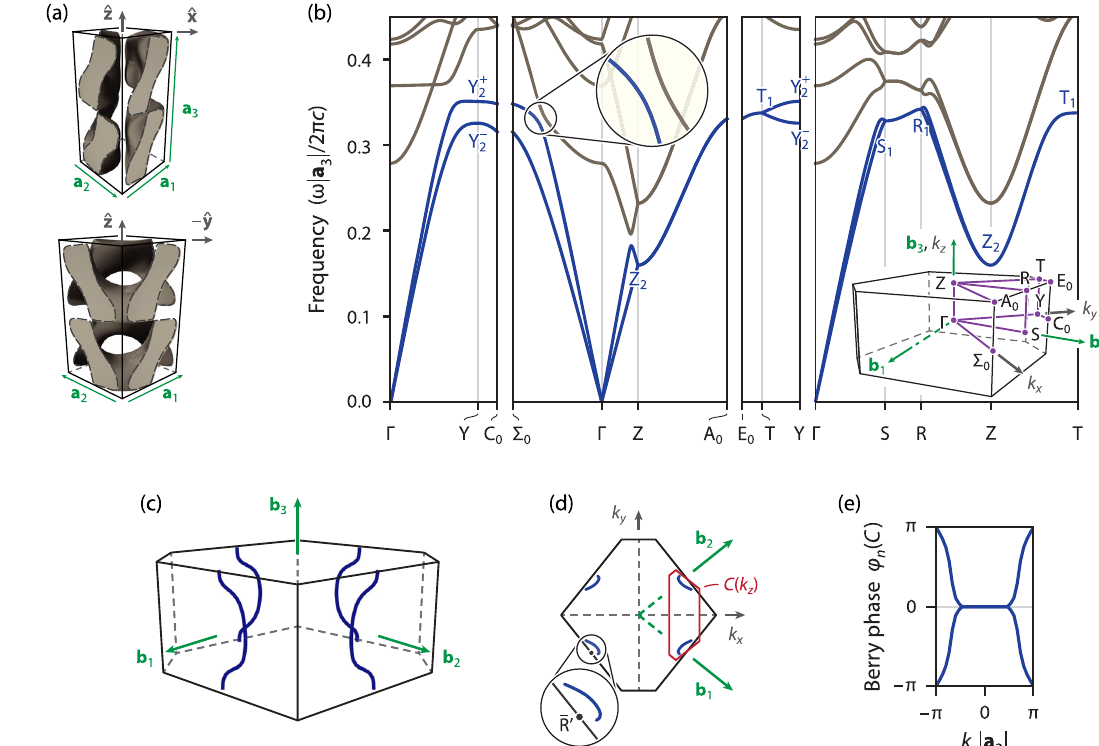
FIG. 4. Photonic topological nongap in space group 68 (Ccce) with Z 2 monopole charge. (a) PhC unit cell and (b) associated band structure (along the indicated BZ path) that realizes a minimum-connectivity ( μ T ¼ 2 ) Γ -enforced topological solution in space group 68 (unit-cell parametrization in Supplemental Table S4 [37]; ε ¼ 16 material in gray, embedded in vacuum with a filling fraction of 35%; a and b , direct and reciprocal primitive lattice vectors). (c) Nodal lines connecting bands 2 and 3 at generic momenta. (d) Projection of i ; k nodal lines to the ð k plane and definition of a fixed- k loop C ð k that encloses a pair of nodal lines. (e) Non-Abelian Berry phases x y Þ z z Þ around C ð k of bands 1 and 2 wind relatively when k ranges over its domain. The nodal lines are consequently protected by a Z 2 z Þ z monopole charge (in addition to a π -Berry